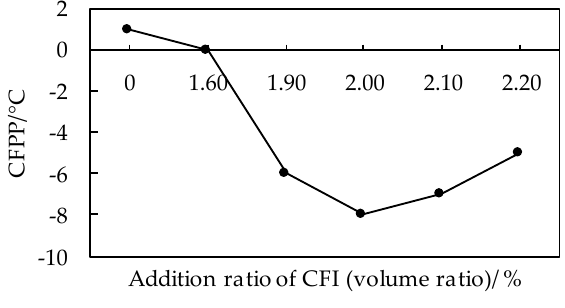
Figure 3. E ff ects of CFI on Figure 3. Effects of CFI on B50. Figure 3. Effects of CFI on B50. Figure 3. Effects of CFI on B50.